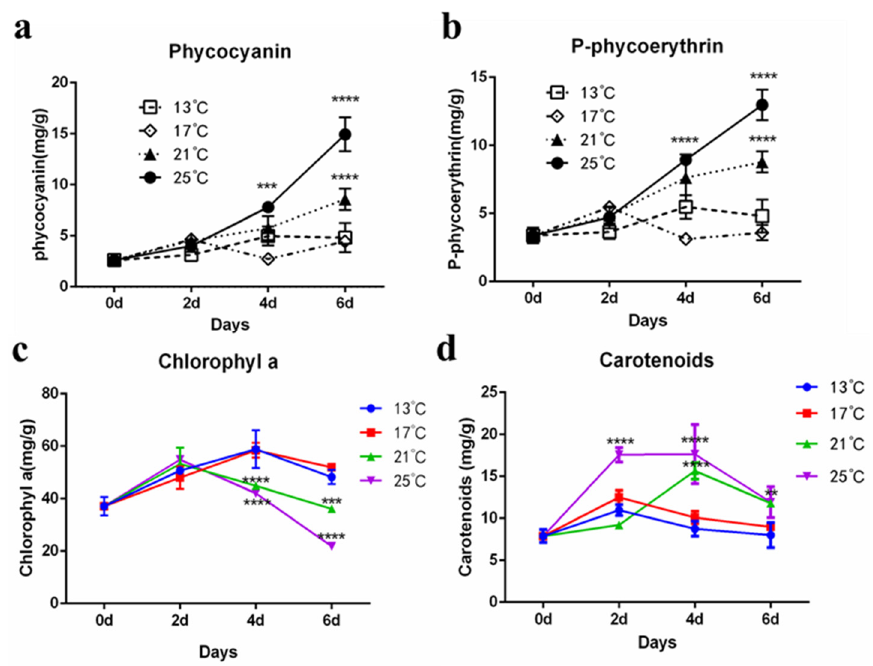
Figure 2. Changes of pigment contents in N. yezoensis incubated at different temperatures. ( a , b ): the content of phycoerythrin and phycocyanin; ( c , d ): the content of Chl a and Car; 0 d represented incubation of the algae at different temperatures for 4 h. Data represent mean ± standard errors ( n = 3). ** p < 0.01, *** p < 0.001, **** p < 0.0001, vs. 13 °C.